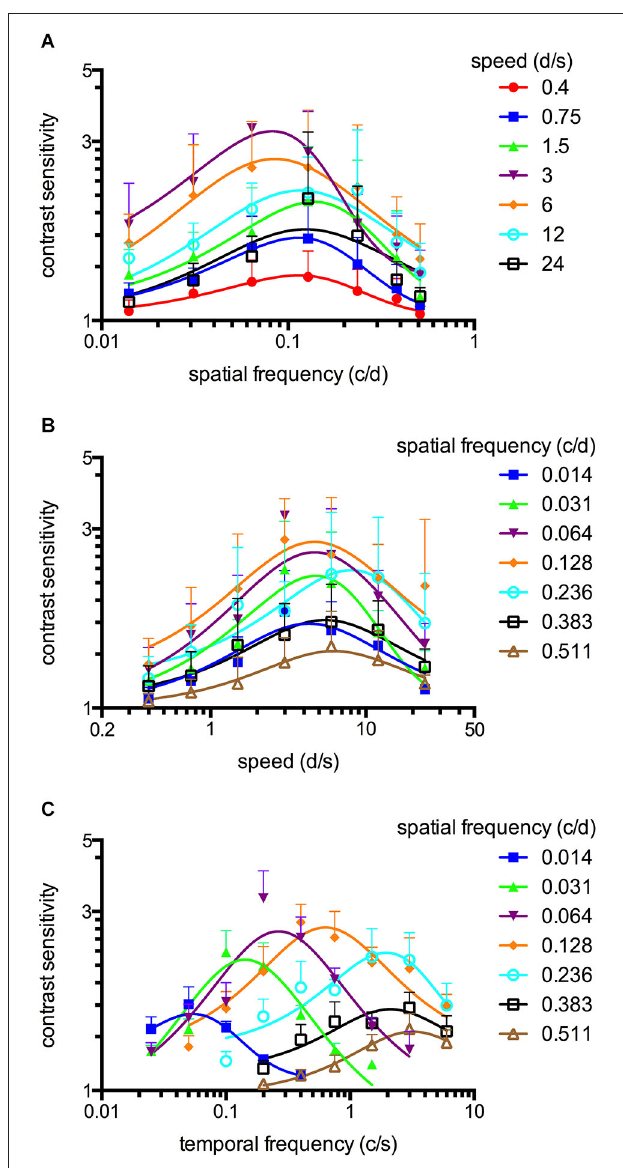
FIGURE 3 | Spatiotemporal contrast sensitivity functions (CSFs) of adult zebrafish at a constant scotopic light level ( − 4.5 log cd m − 2 , n = 6 animals). (A) CSFs of varying speed measured at spatial frequencies ranging from 0.014 to 0.511 c/d. (B) CSFs measured at speed levels ranging from 0.4 to 24 d/s. (C) CSFs measured at temporal frequencies ranging from 0.025 to 6 cycles/second (c/s). Error bars indicate the standard